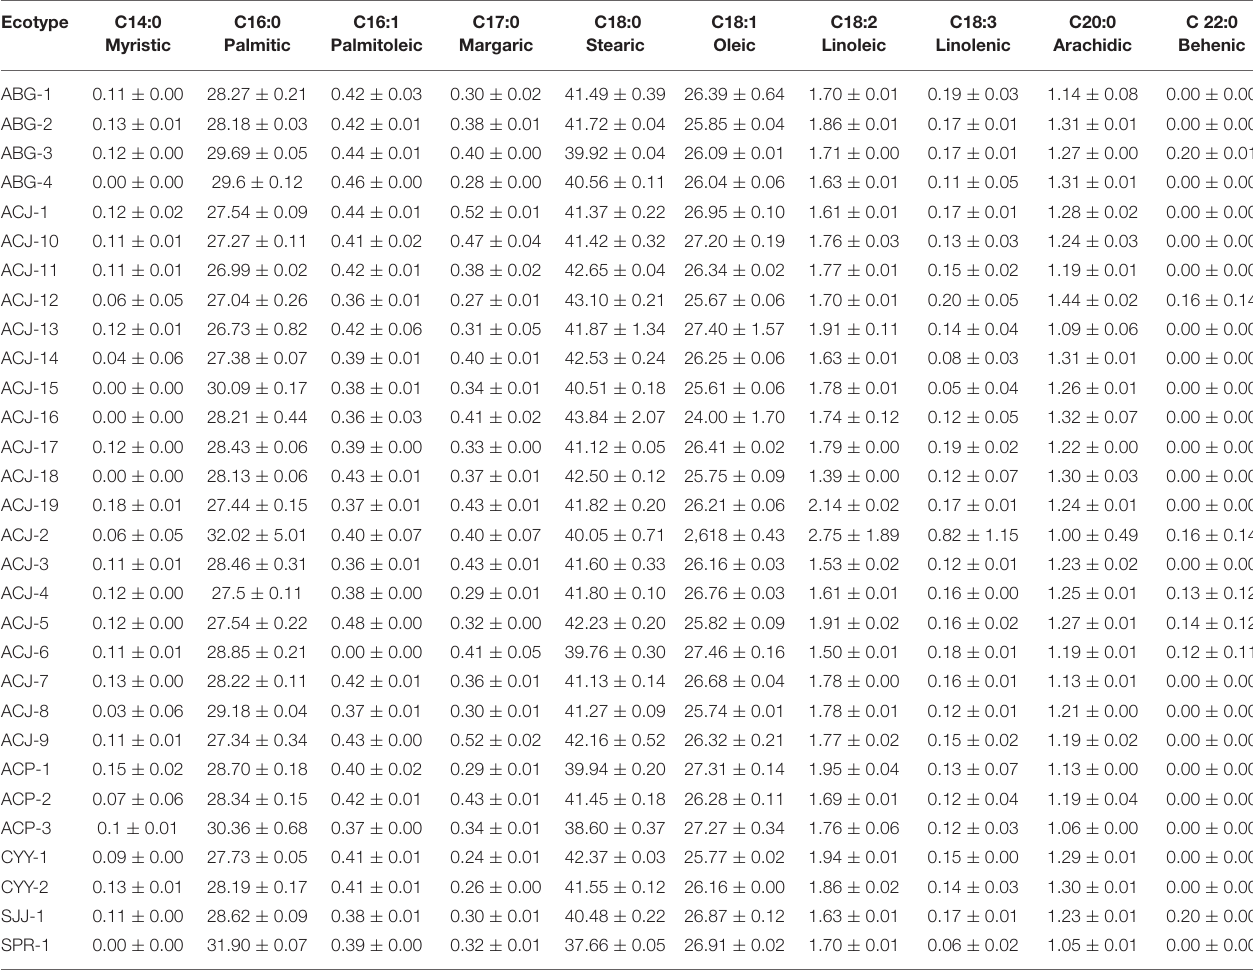
TABLE 2 | Fatty acid profile of 30 ecotypes of fine-aroma native cocoa from northeastern Peru (means ± standard deviation).